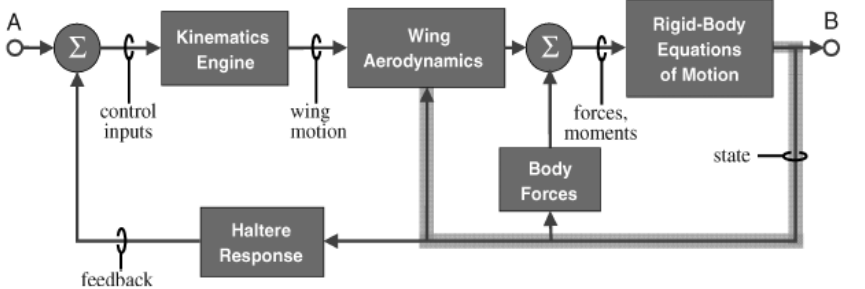
Figure 6. The system identification block diagram for the full nonlinear model of Drosophila Melanogaster flight dynamics [117].